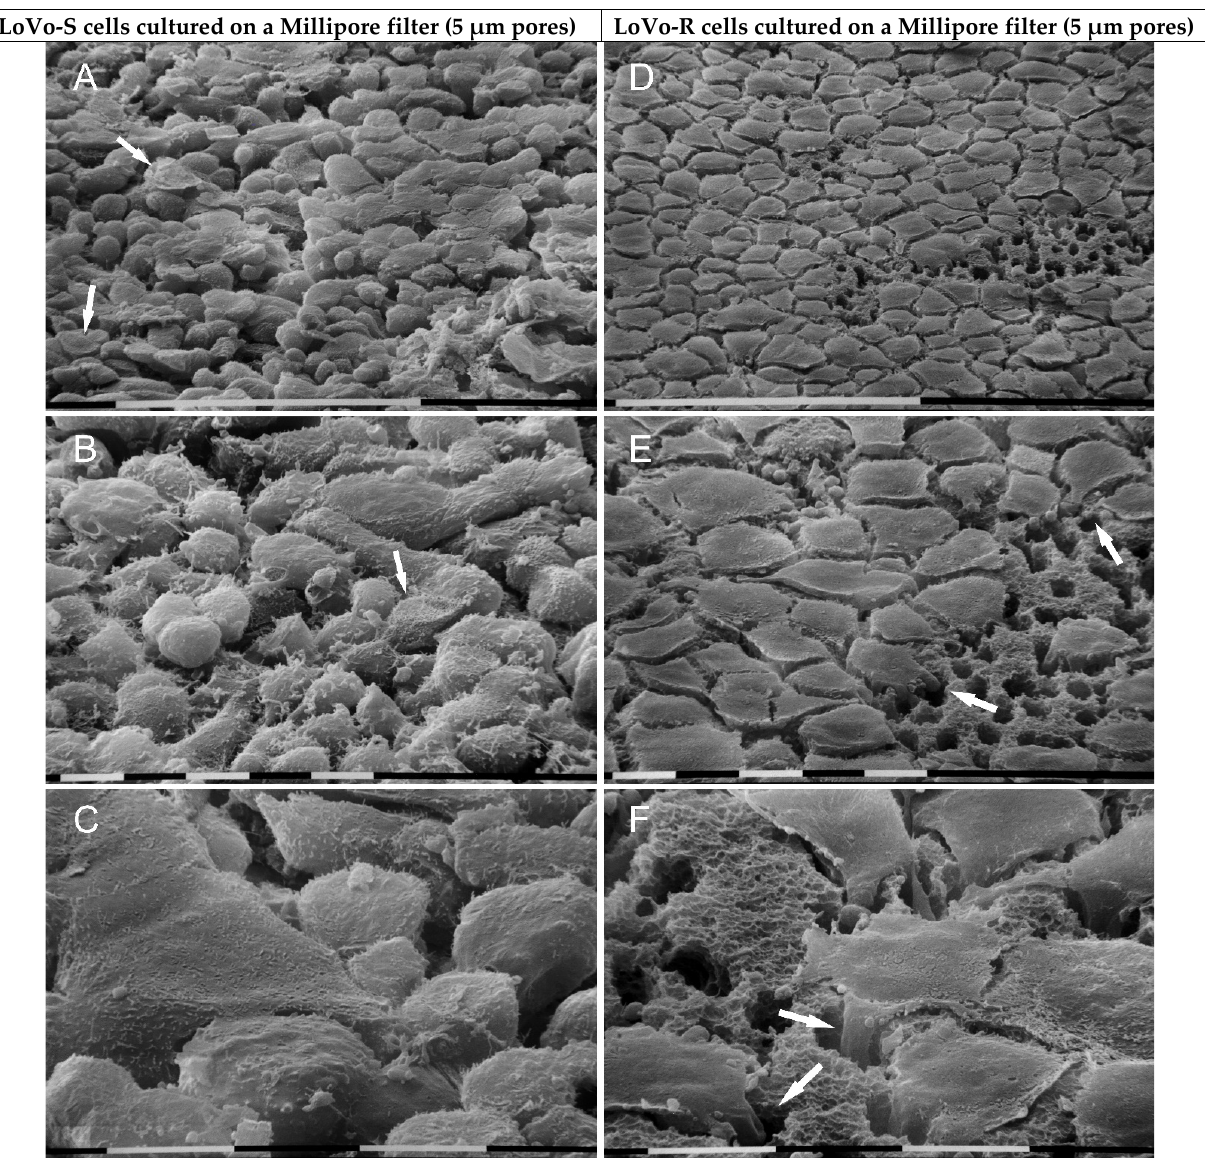
Figure 2. Ultrastructural morphology of LoVo-S and LoVo-R cells cultured for 24 h on a Millipore filter. LoVo-S cells show grouped flattened cells but also globular ones. All of them display cell-cell contacts. A number of cells (6%) exhibit a concave conic/funnel shape (arrows) when trying to pass through the Millipore pores ( A , B ). All cells show few microvilli and no microvesicles on their surface ( C ). LoVo-R cells look like smooth, regular, and very flattened cobblestone-shaped cells. They appear next to each other but do not show tight cell-cell contacts. A tilted observation demonstrates that they appear like concave leaves and develop filopodia (arrows) crossing the pores of the Millipore filter ( D – F ). Bar = 100 µm ( A , D ). Bar = 10 µm ( B , C , E , F ).